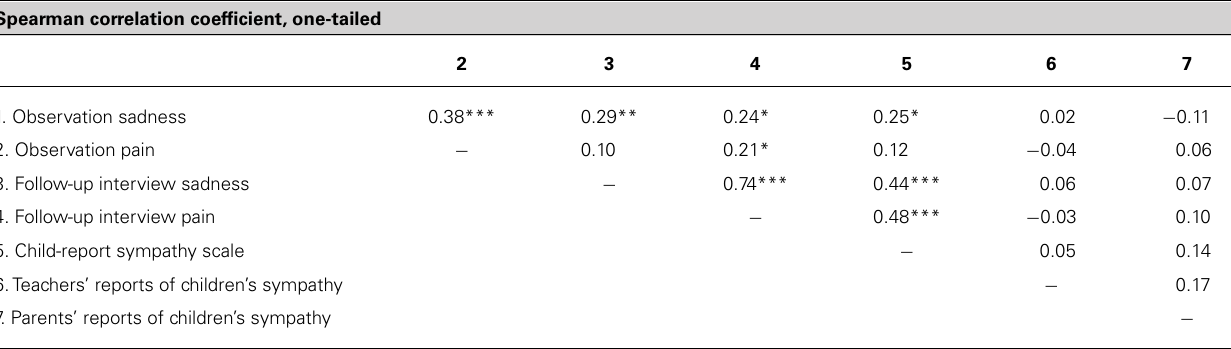
Table 2 | Intercorrelations of the methods measuring sympathyT1. Spearman correlation coefficient, one-tailed